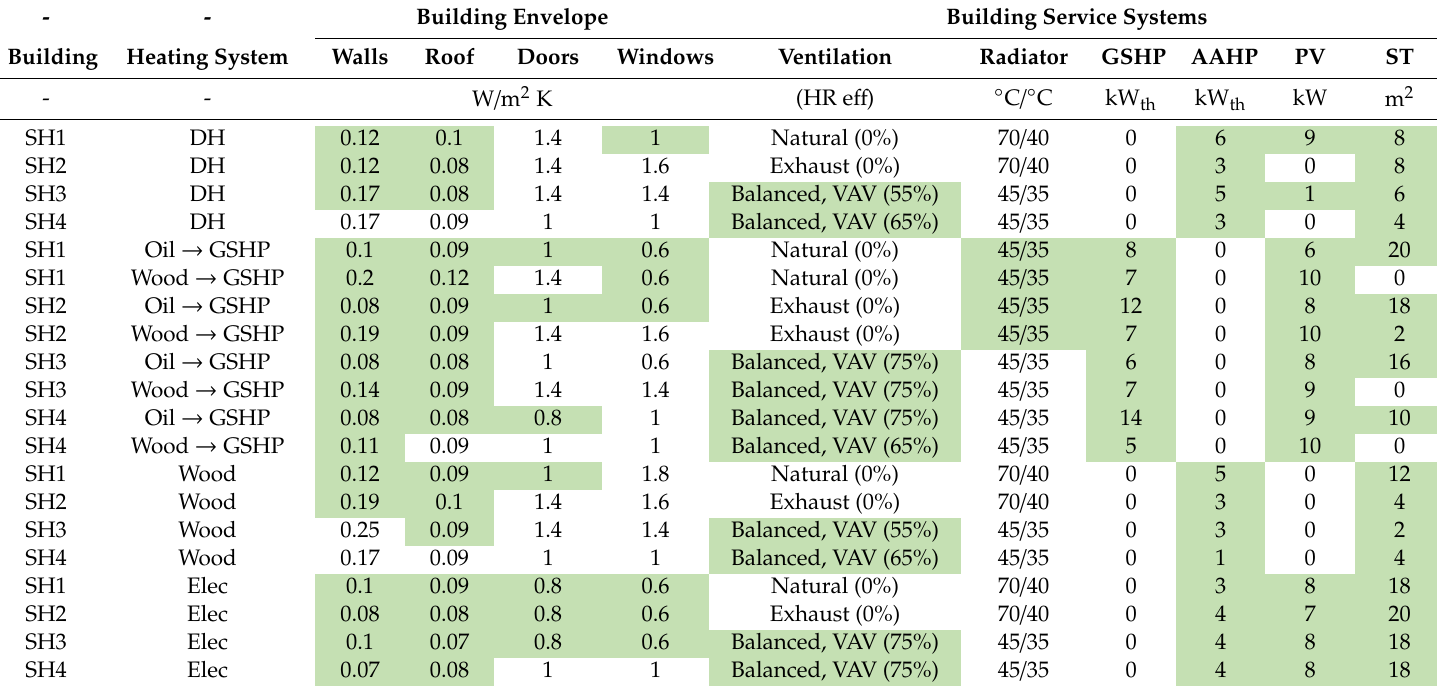
Table 1. Properties of cost-neutrally retrofitted single-family houses (SH). Buildings from four time periods are presented: SH1 (–1975), SH2 (1976–2002),